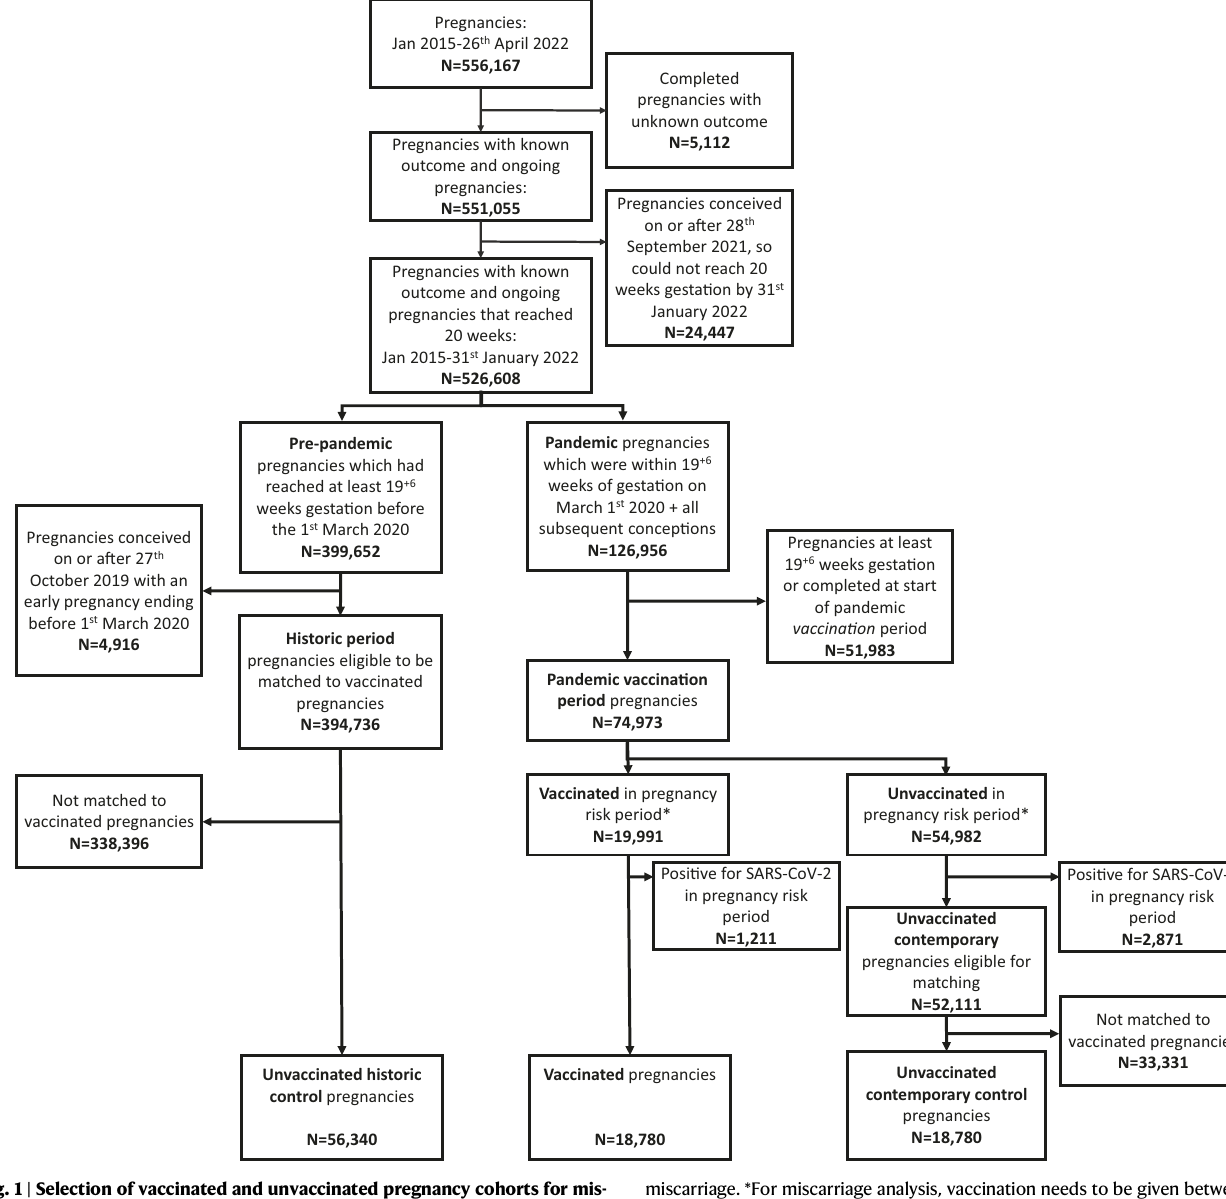
miscarriage. *For miscarriage analysis, vaccination needs to be given between 6weekspreconceptionanduptotheearliestof(1)endofpregnancyor(2)19weeks 6 days